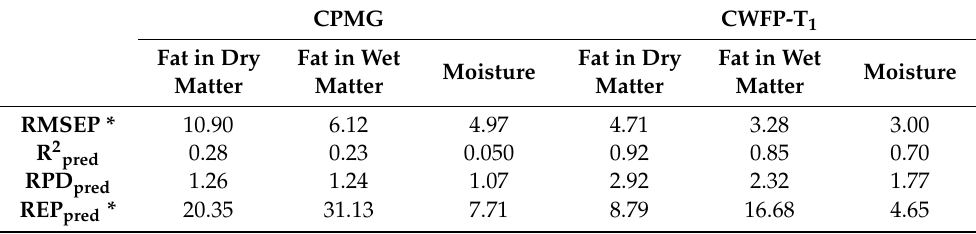
Table 2. PLS models obtained for FDM, FWM, and moisture quantification using the OPS algorithm.